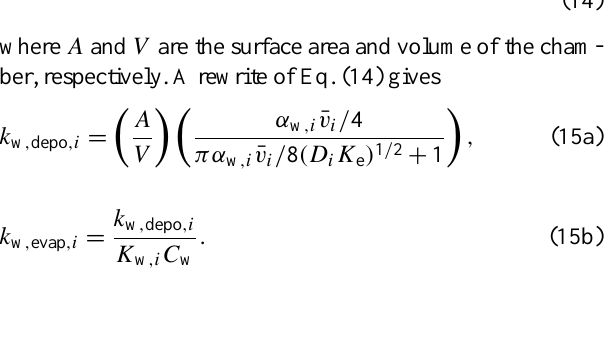
Figure 2. Example of the experimental procedure to assess vapor wall deposition using 3-nitrooxy-6-dodecanol ( m/z = ( − ) 332): pe- riod (1) organic oxidation product generation; period (2) vapor wall deposition at 298K in the dark; period (3) chamber temperature ramp from 298 to 318K; and Period (4) temperature held at 318K in the